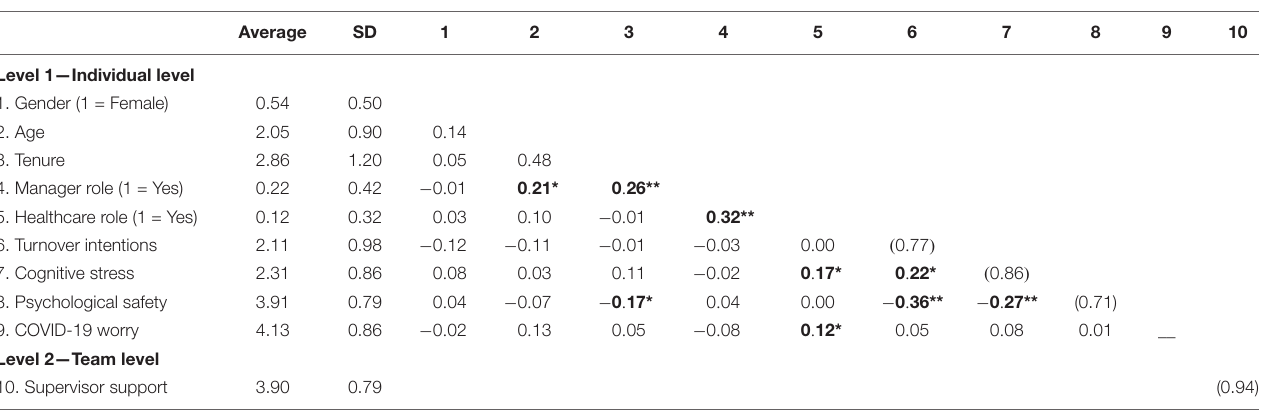
TABLE 2 | Descriptive statistics and correlations.